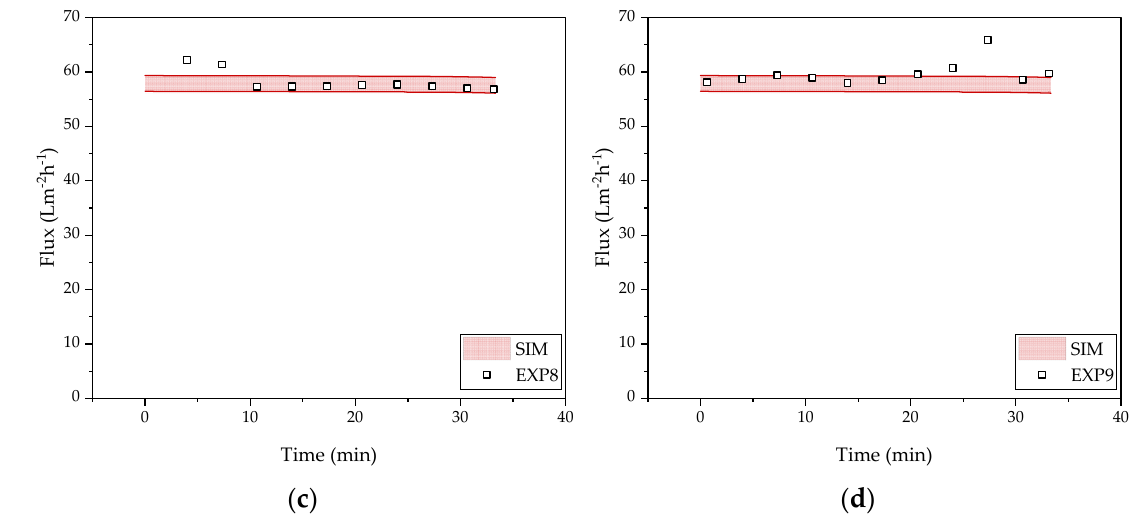
Figure 8. Flux Jv over time for experimental (squares) as well as digital twin prediction (red area) for buffer exchange experiments by ultra-/diafiltration after clarification with experimental conditions: ( a ) Experiment 1 (EXP1): 1.4 bar transmembrane pressure (TMP), 2062 s − 1 shear rate. ( b ) Experiment 5 (EXP5): 1.3 bar TMP, 11,633 s − 1 shear rate. ( c ): Experiment 8 (EXP8): 1.3 bar TMP, 6071 s − 1 shear rate. ( d ): Experiment 9 (EXP9): 0.8 bar TMP, 6085 s − 1 shear rate.